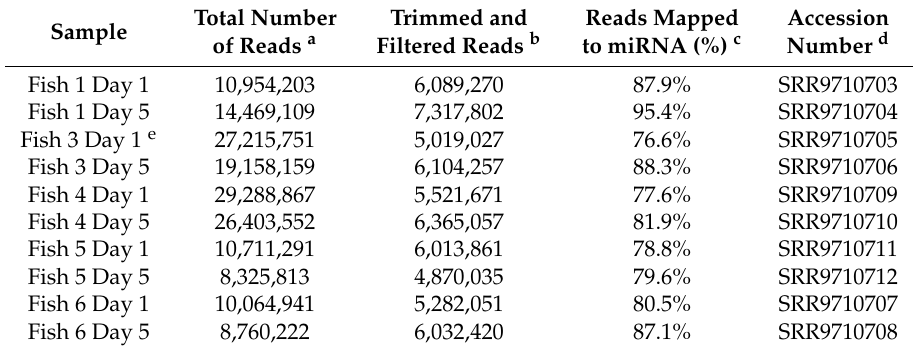
Table 1. Sequencing results.